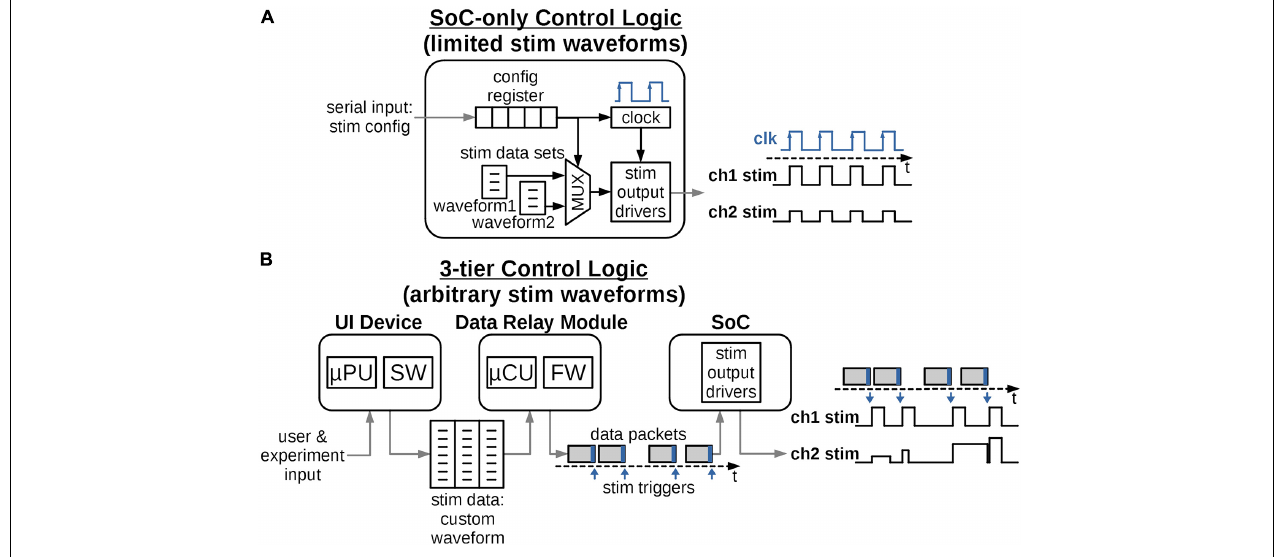
FIGURE 3 | Possible ways to distribute control logic to create the required stimulation waveforms. (A) The logic is integrated solely into the digital circuits of the SoC. Provisions are made for a limited set of output waveforms with short, periodically repeating patterns. The design is fixed and future waveform protocols would require challenging and costly redesign of the SoC. (B) The control logic is distributed into 3-tiers and accommodates a variety of arbitrary and biomimetic stimulation waveforms. The logic can be reprogrammed for future protocols relatively easily and at low